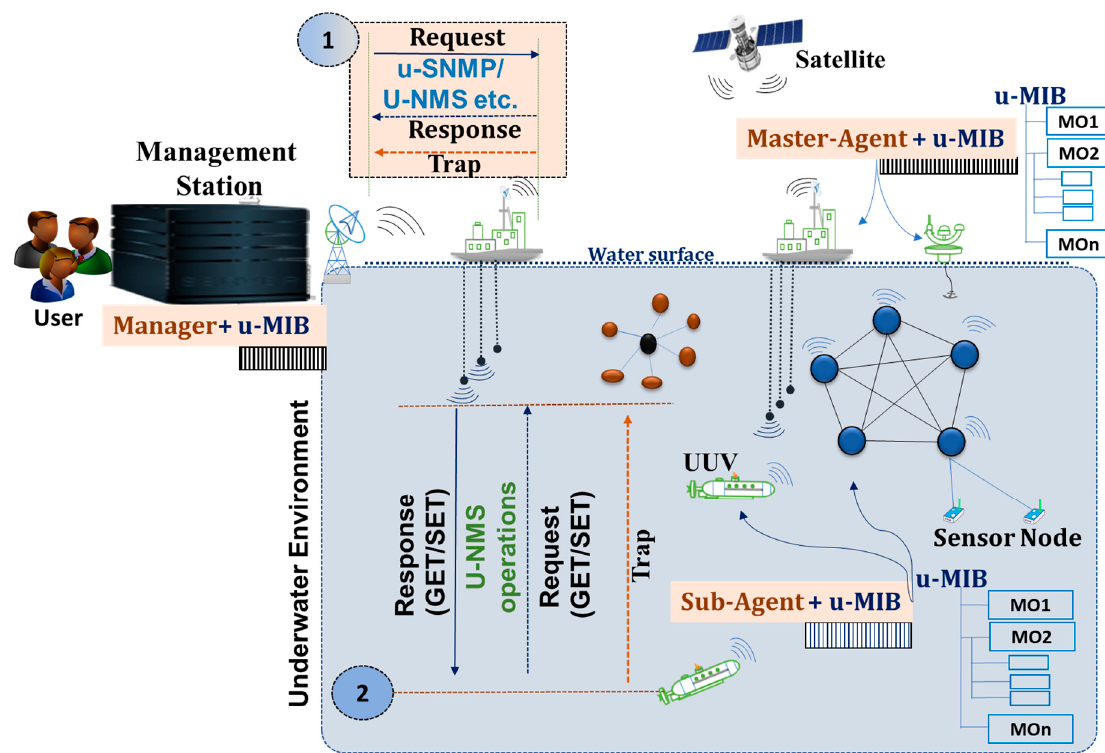
Figure 4. U-NMS components and request/response operation in IoUT [87].